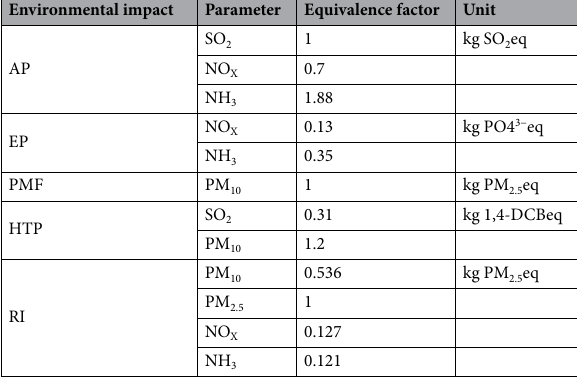
Table 2. Selection of environmental impact categories.